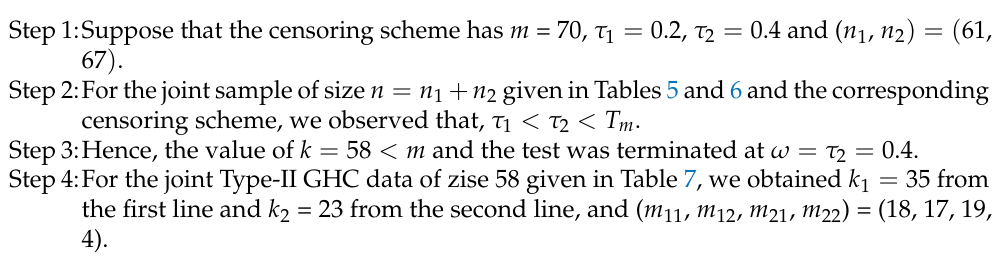
Algorithm 4 Generate joint Type-II GHC competing risks data.